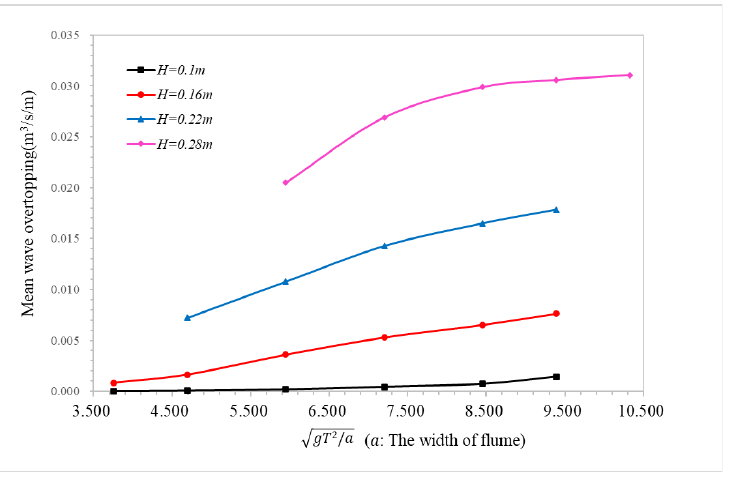
(cid:112) 2 / g T a gT 2 / a . .